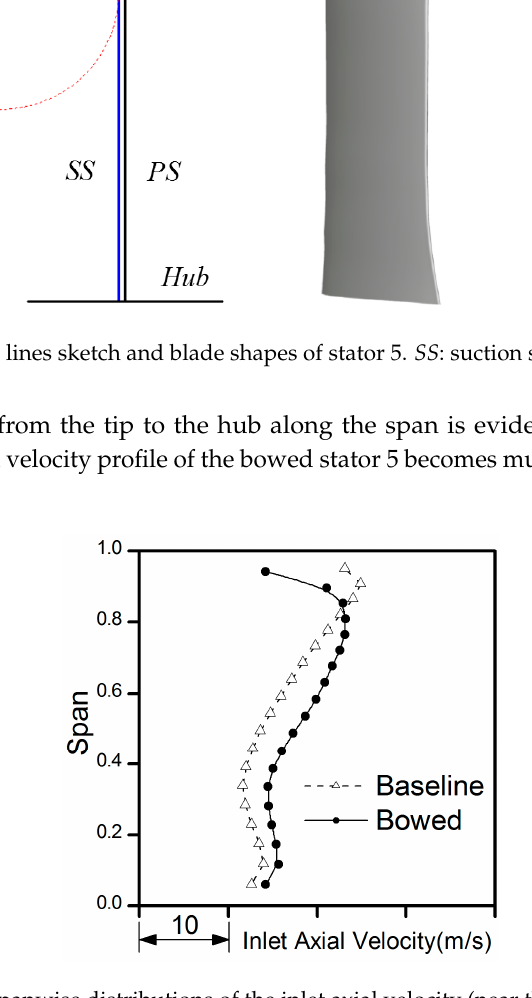
Figure 12. Spanwise distributions of the inlet axial velocity (near the stall points).